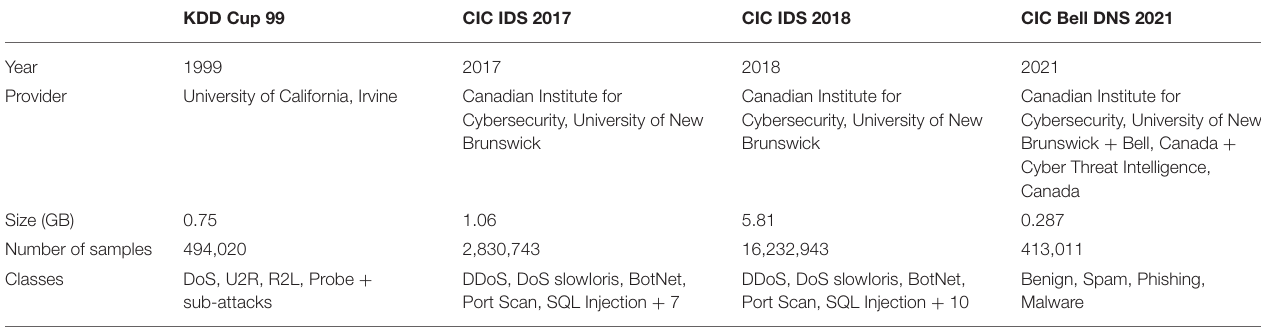
TABLE 1 | Comparison of KDDCup99, CIC IDS variants, and CIC Bell DNS 2021 datasets.